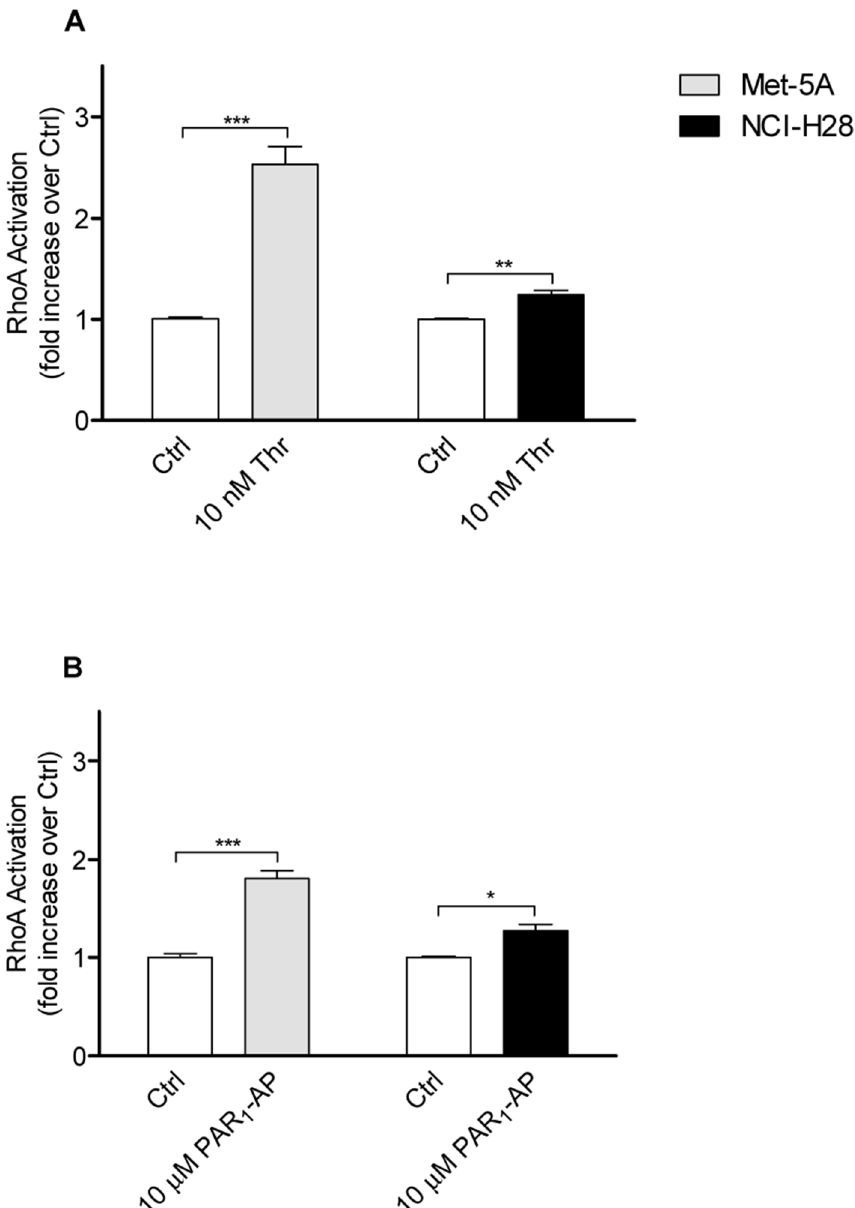
Figure 5. PAR 1 agonist-induced G 12/13 signaling is impaired in NCI-H28 cells. A, relative levels of RhoA activation in response to thrombin in Met-5A and NCI-H28 cells. B, relative levels of RhoA activation in response to the selective PAR 1 -AP in Met-5A and NCI-H28 cells. Rho A activation was measured in serum and growth factor starved cells using the RhoA G-LISA kit from Cytoskeleton. Data shown are mean 6 SEM of three independent experiments performed in triplicate. The differences in RhoA activation between Ctrl (vehicle treated Met-5A or NCI-H28 cells) and agonist-treated cells were significant (*P # 0.05, **P # 0.01, ***P # 0.001) by one-way ANOVA followed by Bonferroni’s multiple comparison test (n=3).